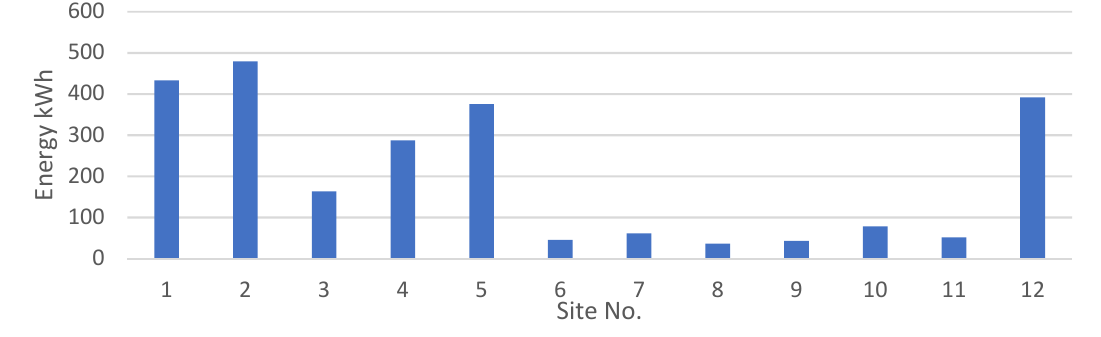
Figure 8. Total energy consumption at each site.